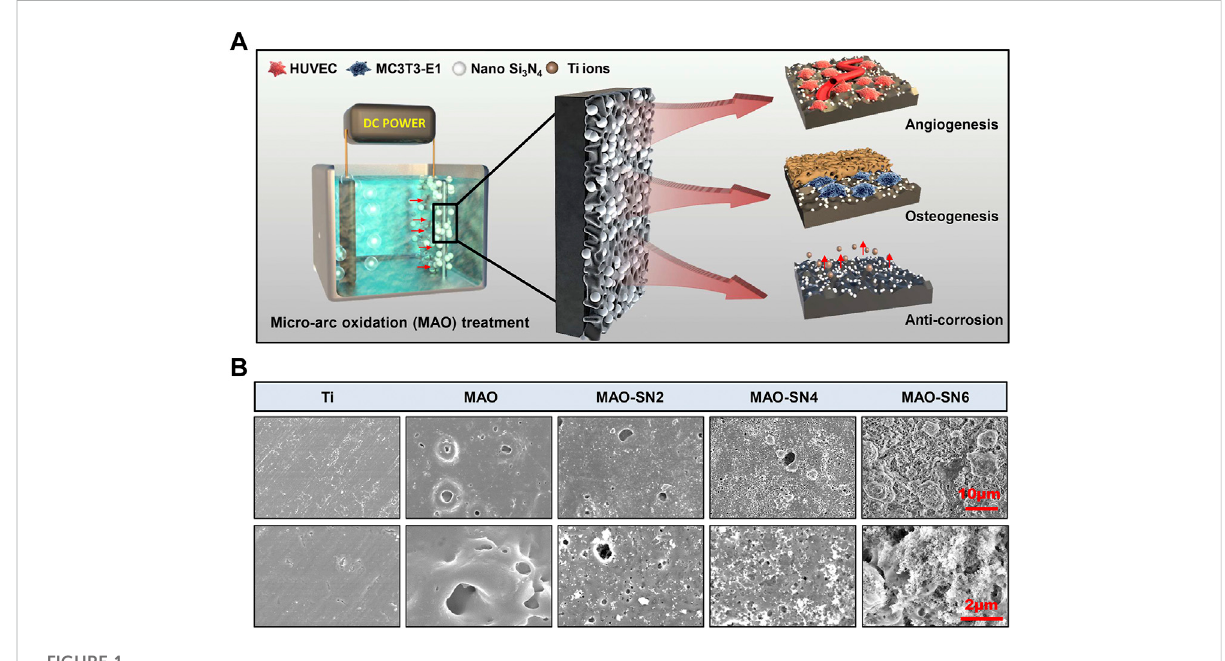
FIGURE 1 (A) Schematic diagram of the micro-arc oxidation treatment of titanium and its osteogenic/angiogenic/corrosion resistant properties. (B) Representative SEM images of the Ti, MAO, MAO-SN2, MAO-SN4, and MAO-SN6